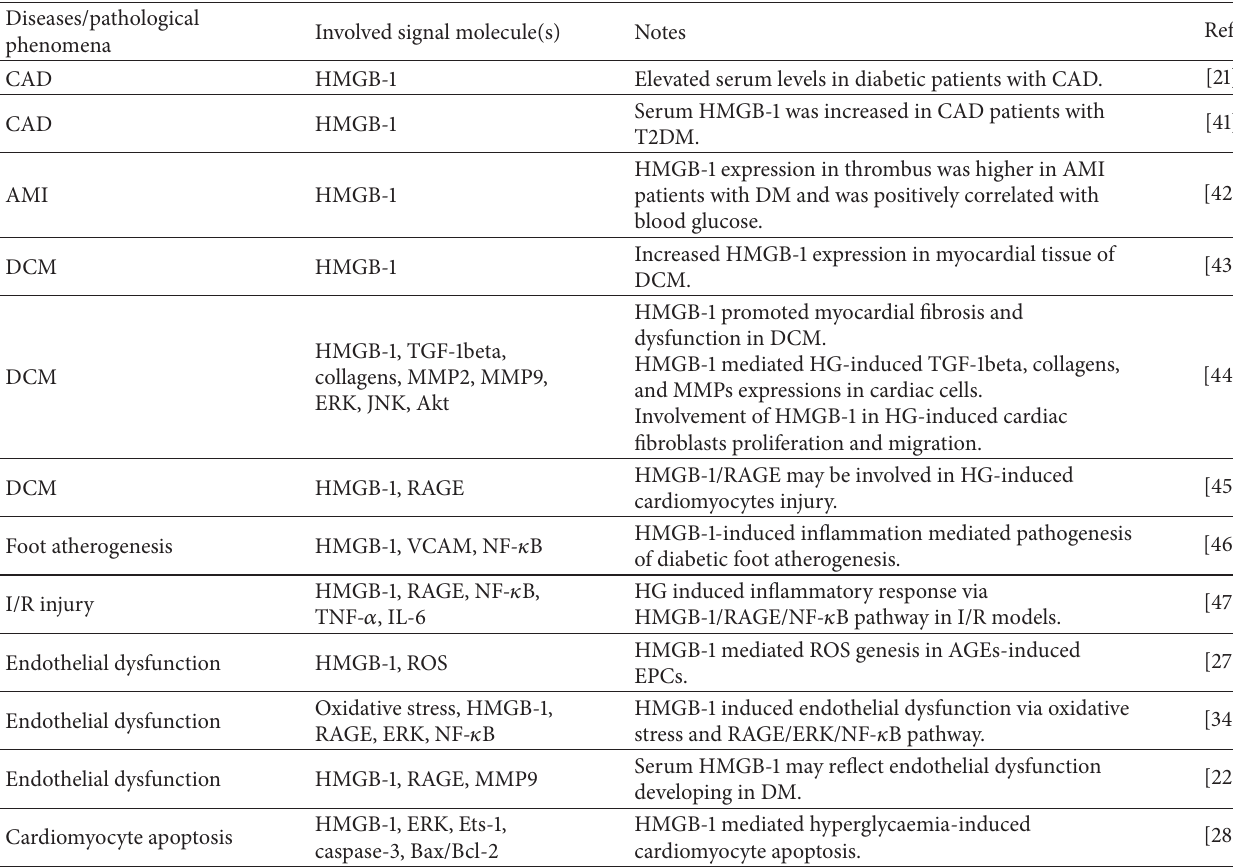
Table 1: Functions of HMGB-1 in diabetic cardiovascular